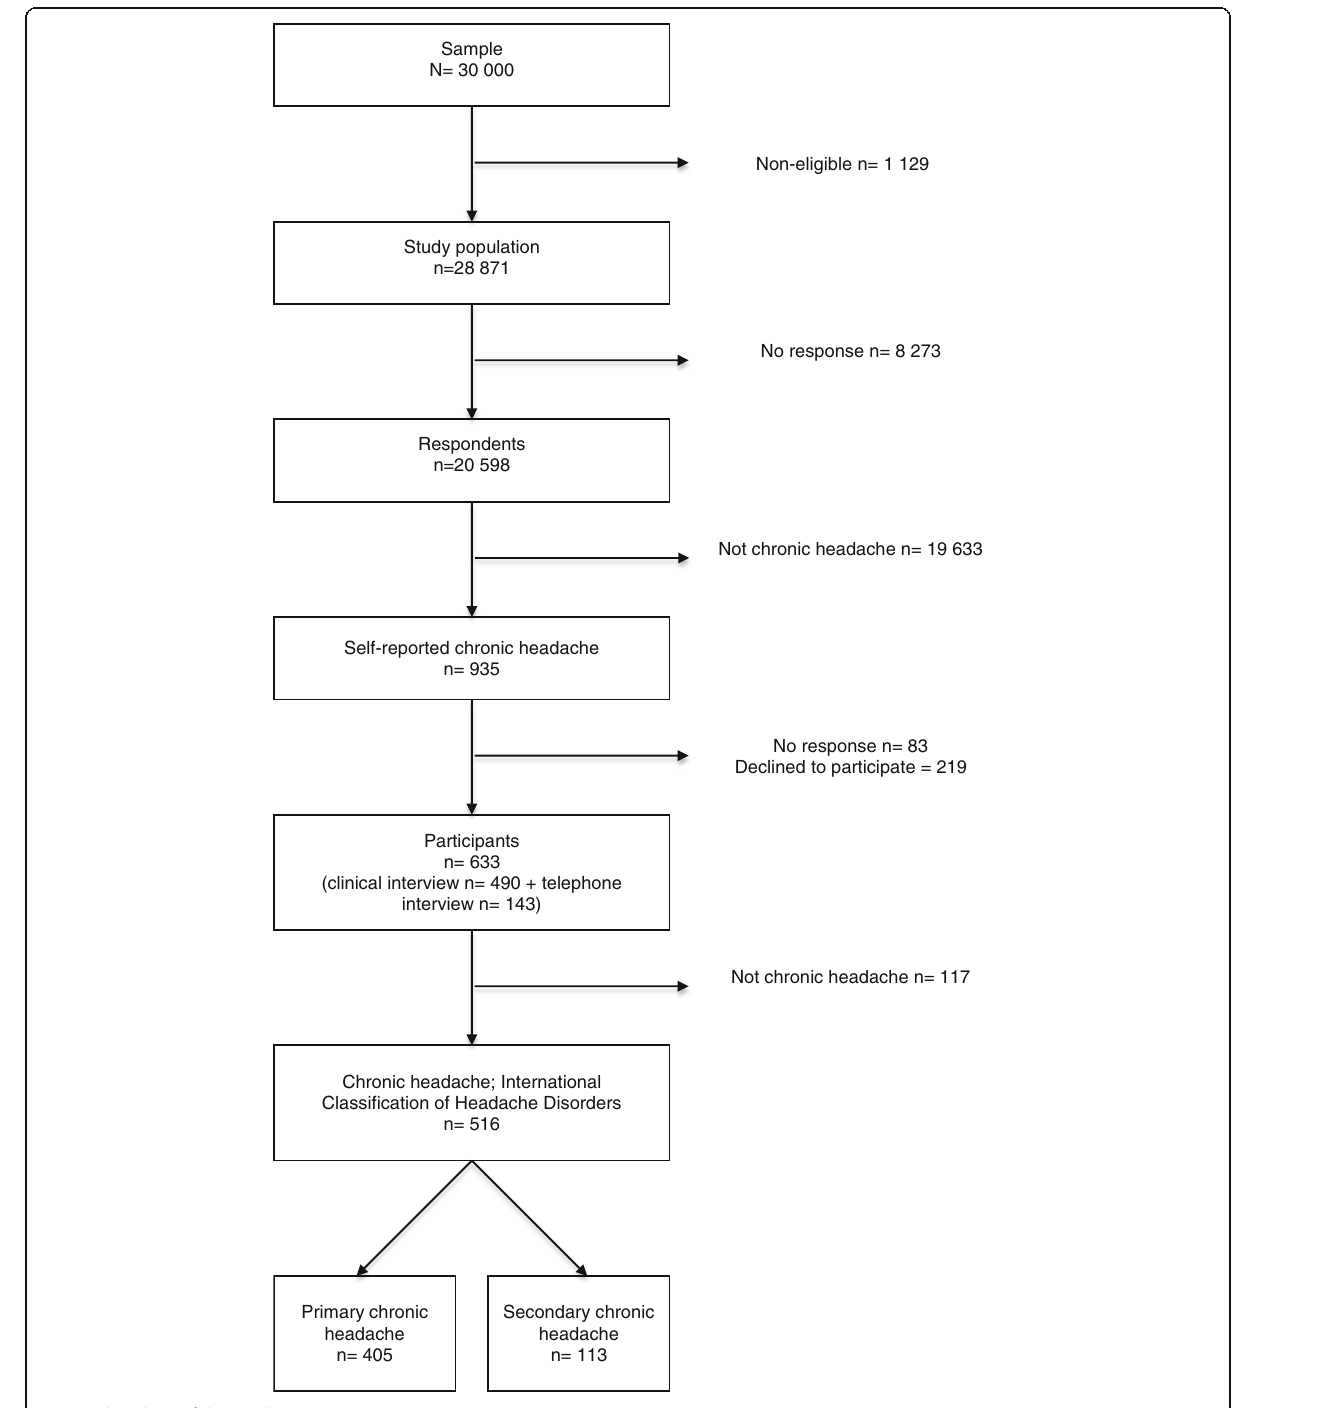
was also, in addition, defined according to the criteria established by the American Academy of Otolaryngology – Head and Neck Surgery (Textbox 2b) adding that the symptoms had persisted for 12 weeks or more